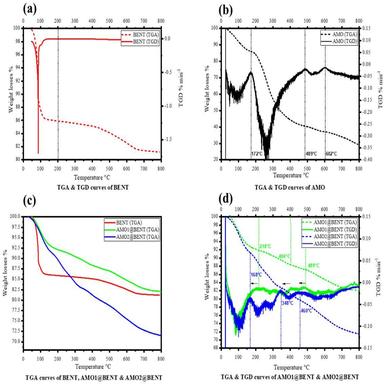
TG curves of (a) BENT; (b) AMO; (c) BENT, AMO1@BENT and AMO2@BENT; (d) AMO1@BENT and AMO2@BENT.